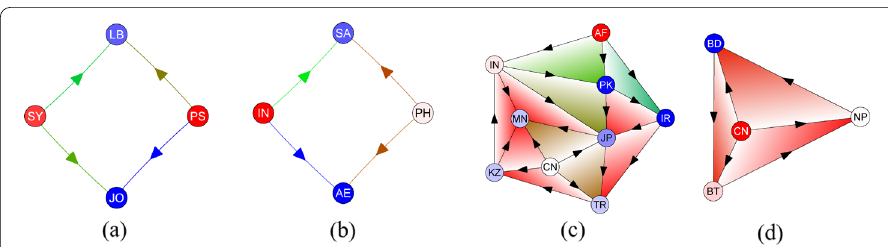
Figure 16 Persistent cycles of migration. ( a ) The second most persistent 1-cycle in the Asian net migration network. This 1-cycle corresponds to the lowest bar in the 1-dimensional barcode in Fig. 9(a). ( b ) The most persistent 1-cycle in the Asian net migration network. ( c ) and ( d ) Perpetual 2-cycles in the Asian net migration network